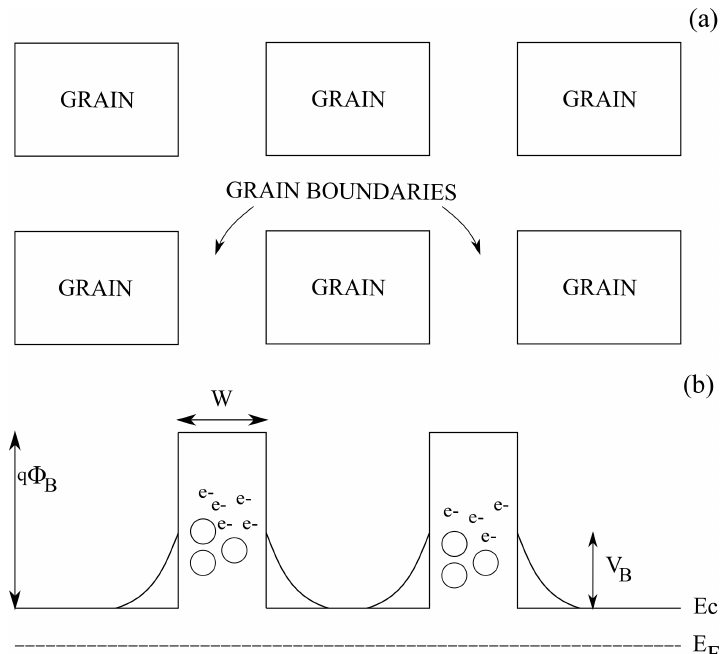
Figure 15. ( a ) Crystallites organization in polycrystalline films. ( b ) Energy band diagram showing the trapped electrons in the grain